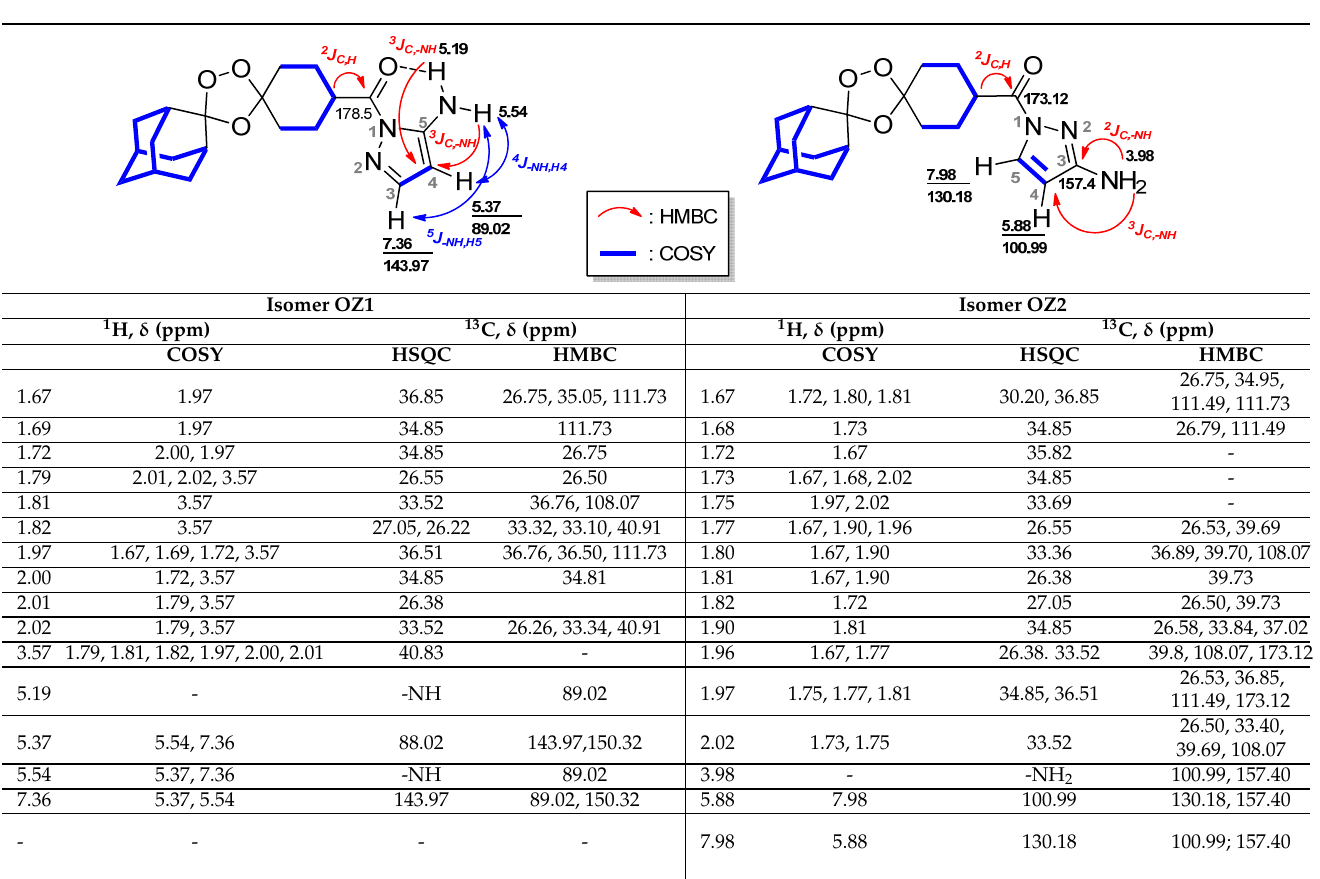
Table 1. Correlations found in the HSQC, and HMBC spectra of 1,2,4-trioxolane–pyrazole isomers OZ1 and OZ2 .